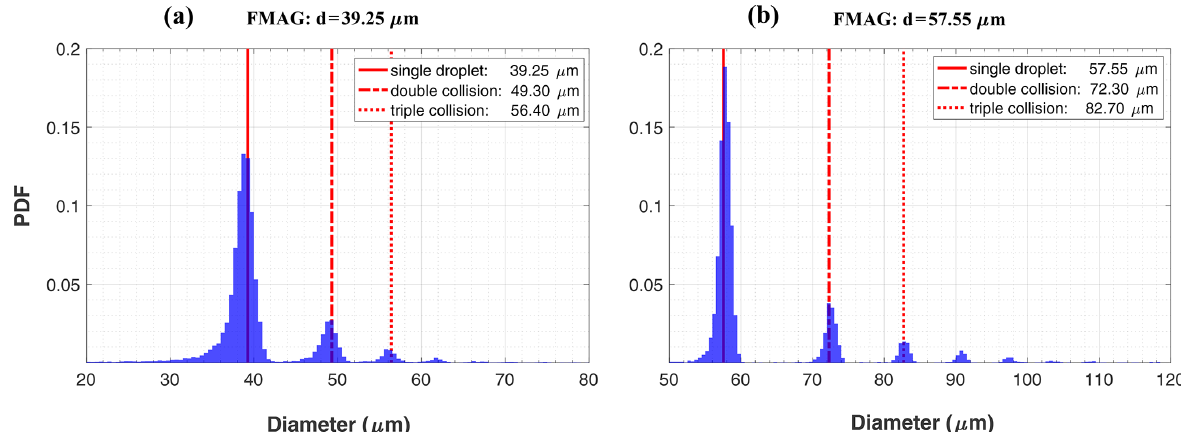
Figure 13. Probability distributions of droplet size measured by the VisiSize D30 in the configuration shown in Fig. 10b (the distance between the sample volume and the nozzle head is ∼ 18 . 5cm) for camera lens magnification setting × 1. The initial size of the generated droplets as well as the droplet sizes after double and triple collisions are marked with vertical red lines.